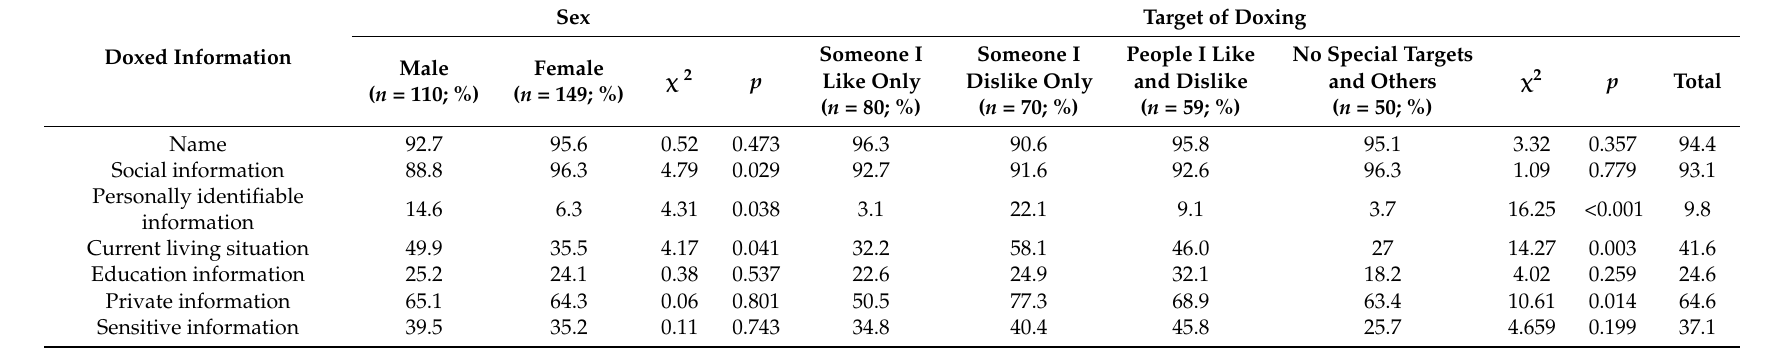
Table 4. Personal information on targets obtained through doxing ( n =